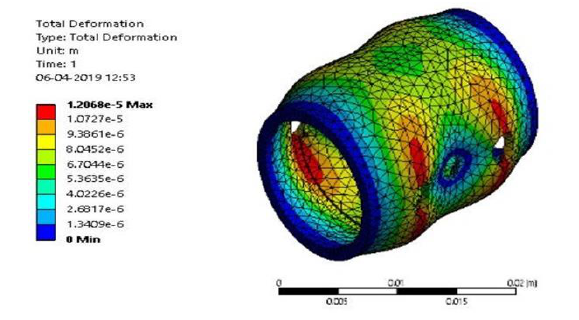
Fig. 12. Deformed babbitt 1 under pressure from oil film